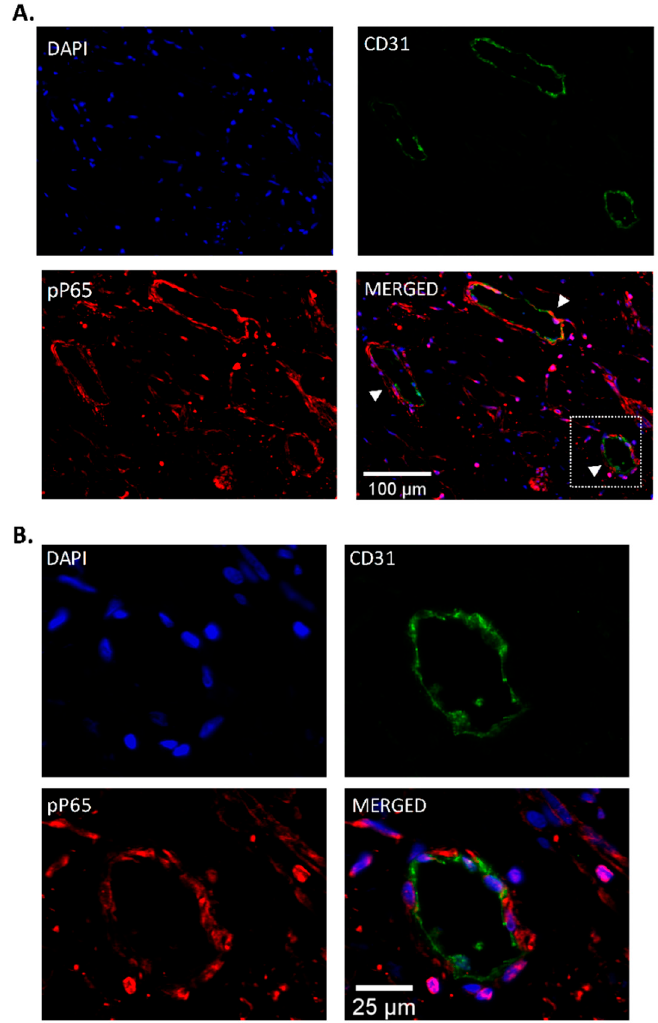
Figure 3. Pulmonary endarterectomy (PEA) immunofluorescence. ( A ) Representative images showing the localization of phospho-NF- κ B-P65 (pP65) in vessels in endarterectomy specimens from patients with CTEPH (n = 8), using double labeling with CD31/PECAM (green) and pP65 (red). ( B ) pP65 immunoreactivity was observed in endothelial cells from vessels within the thrombus (magenta, indicated by the white arrows). Nuclei were counterstained with DAPI (blue). Scale bar, 100 μ m (panel ( A )) and 25 μ m (panel ( B )).